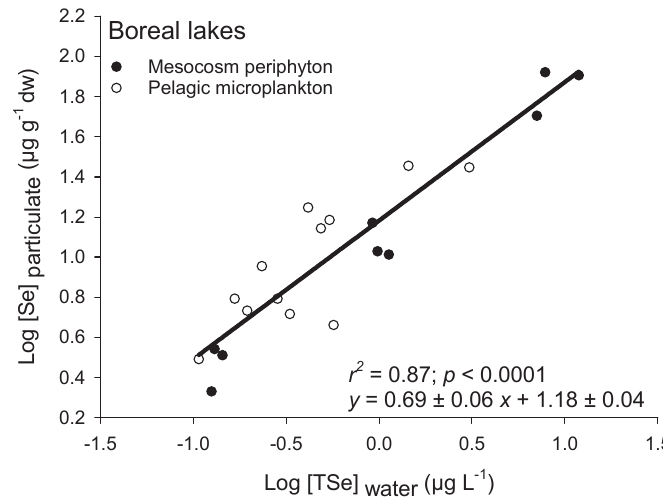
Figure 2. Log-transformed Se concentrations in particulate (Log [Se] particulate ; µ g g − 1 dw) as a function of log-transformed water total dissolved Se concentrations (Log [TSe] water ; µ g L − 1 ). Closed circles are from periphytic biofilms in mesoscosms spiked with Se(IV) in a boreal lake [45] and the open circles are from pelagic microplankton ( < 64 µ m filtered and centrifuged water) collected in 12 boreal lakes in two mining regions [23]. Note that these are among the highest k d s reported in Figure 1C.